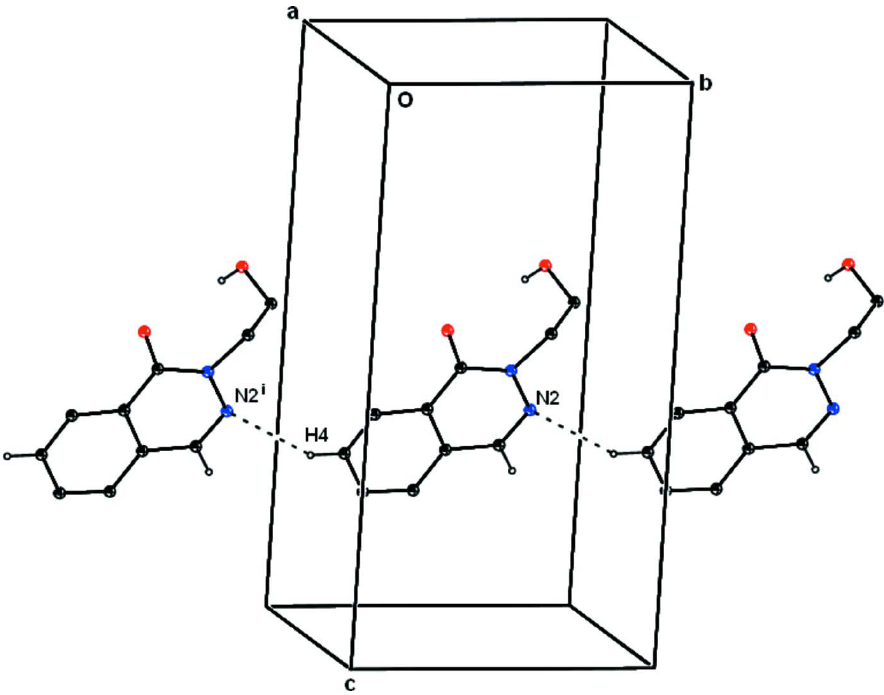
Figure 3 A partial packing diagram of (I), showing the formation of C(7) chain [symmetry code: (i) x, y - 1, z]. H atoms not involved in hydrogen bondings have been omitted for clarity.